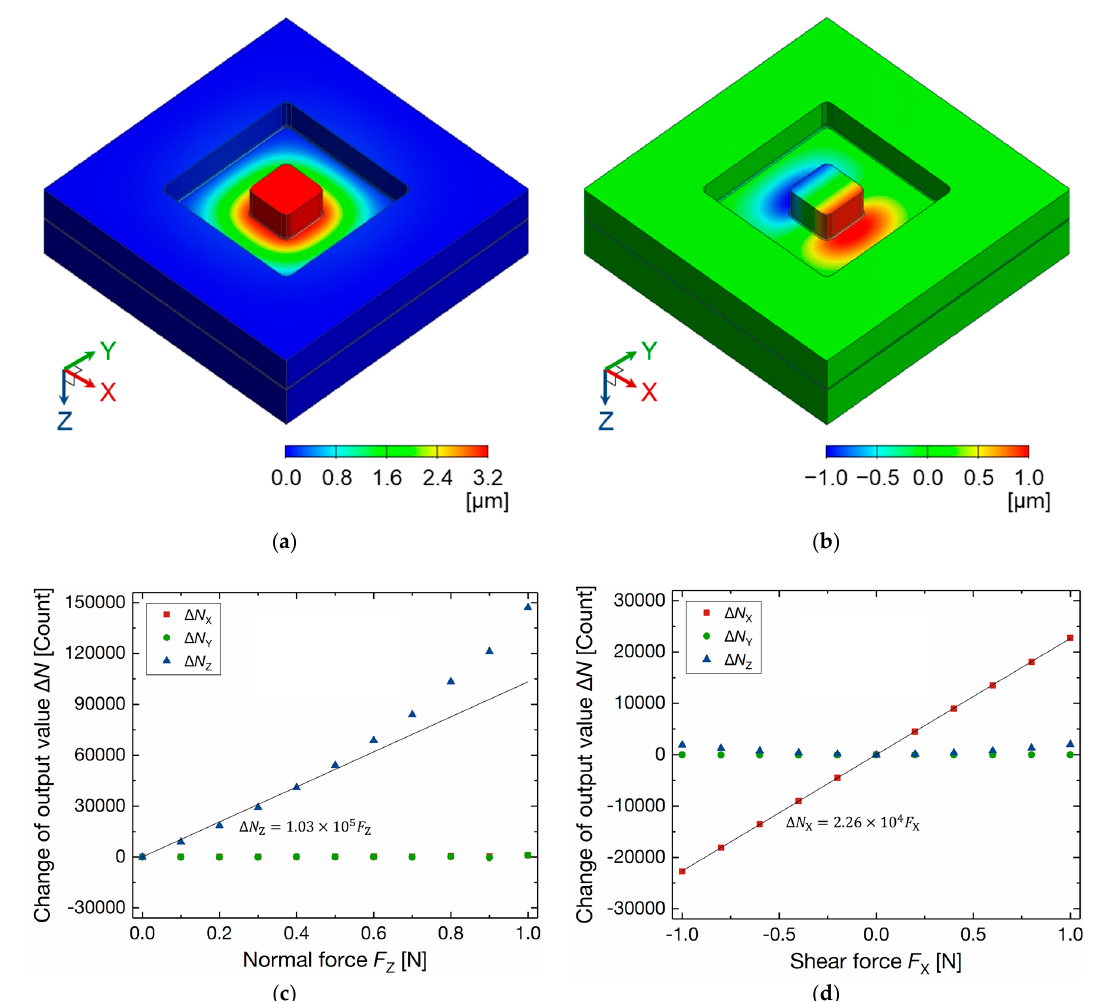
Figure 5. Finite element method (FEM) simulation results: Diaphragm deflection by ( a ) normal force F Z of 1 N and ( b ) X-axis shear force F X of 1 N applied to the positive direction; Calculated change of 3-axis output values by ( c ) F Z and ( d ) F X .